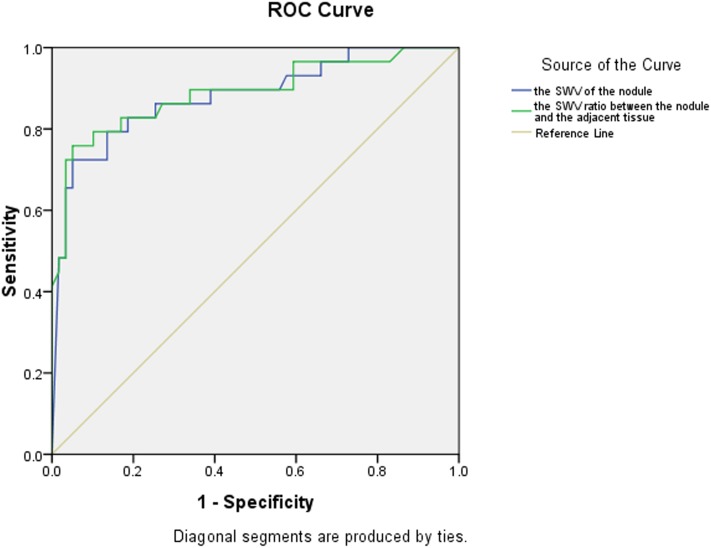
ROC curves of the SWV value and SWV ratio of thyroid nodules.